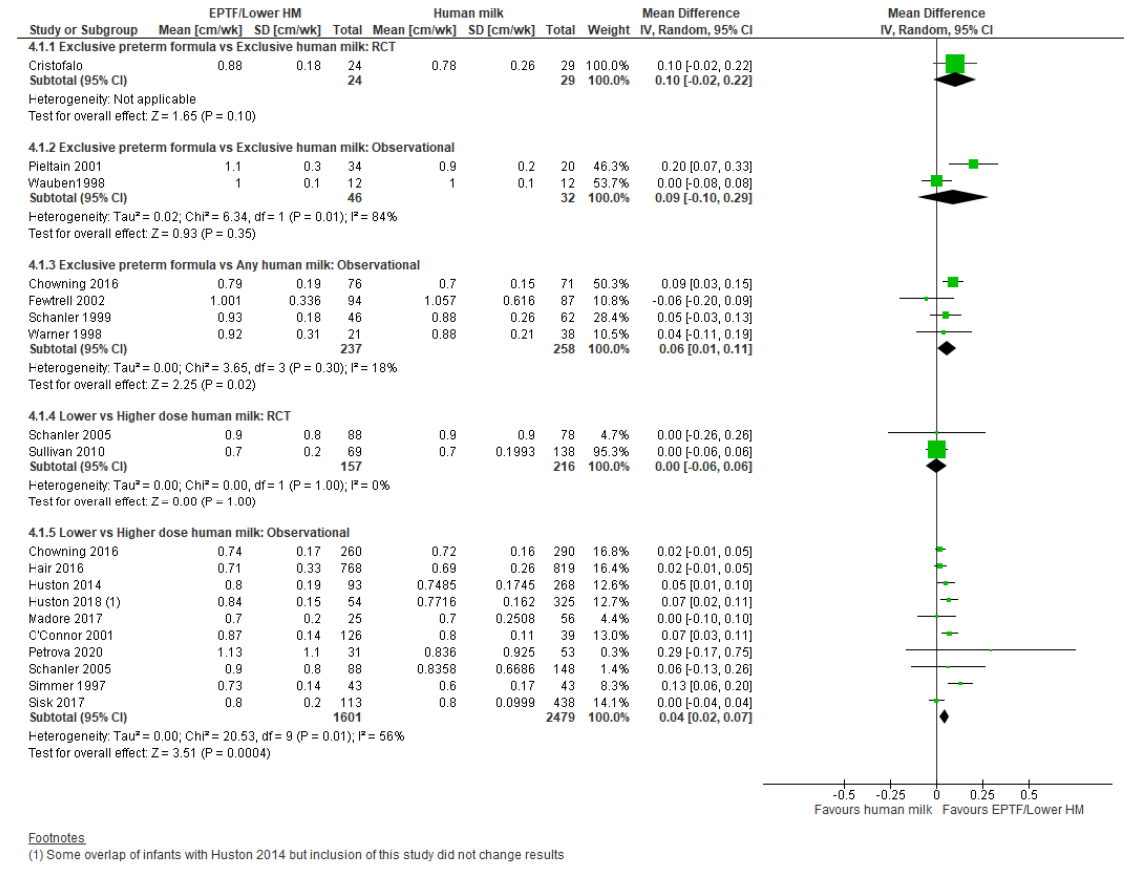
Nutrients 2021 , 13 , x FOR PEER REVIEW Figure 4. Forest plot of mean difference in change in head circumference gain (cm/wk) and human milk intake.